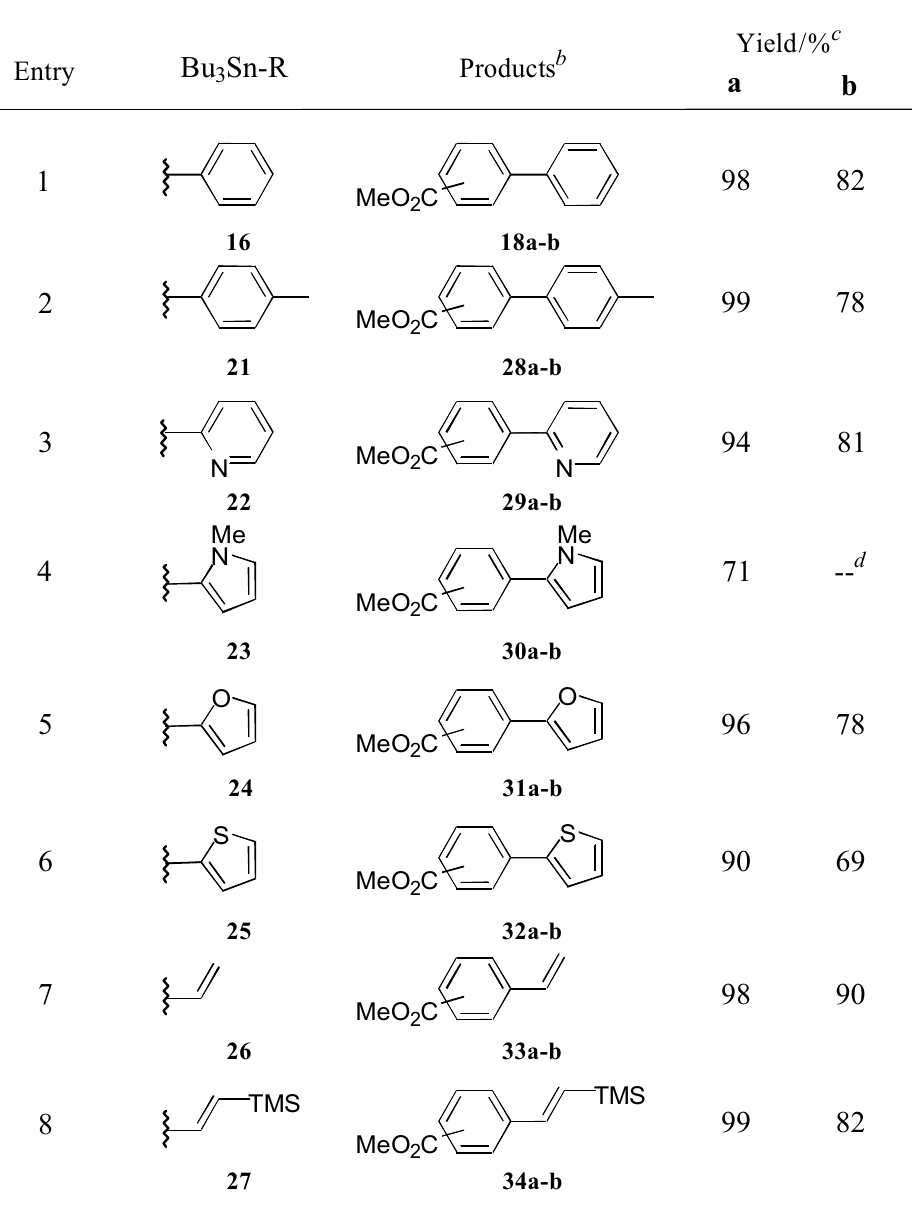
Table 5. Parallel liquid-phase Stille couplings of iodides 15a - b with tributyl stannanes 16 and 21 - 27 a